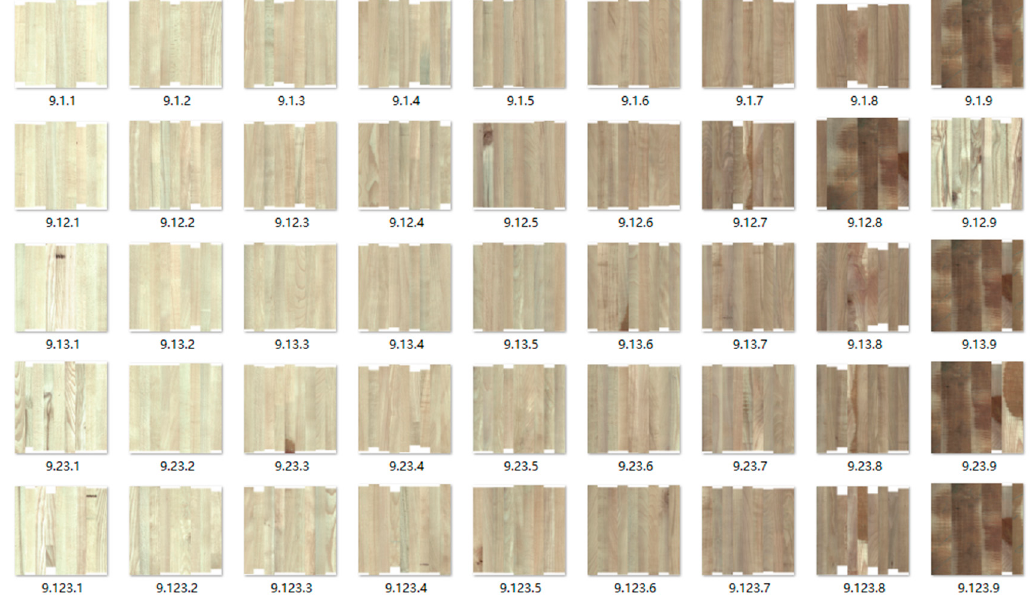
Figure 8. K = 9 clustering result images.